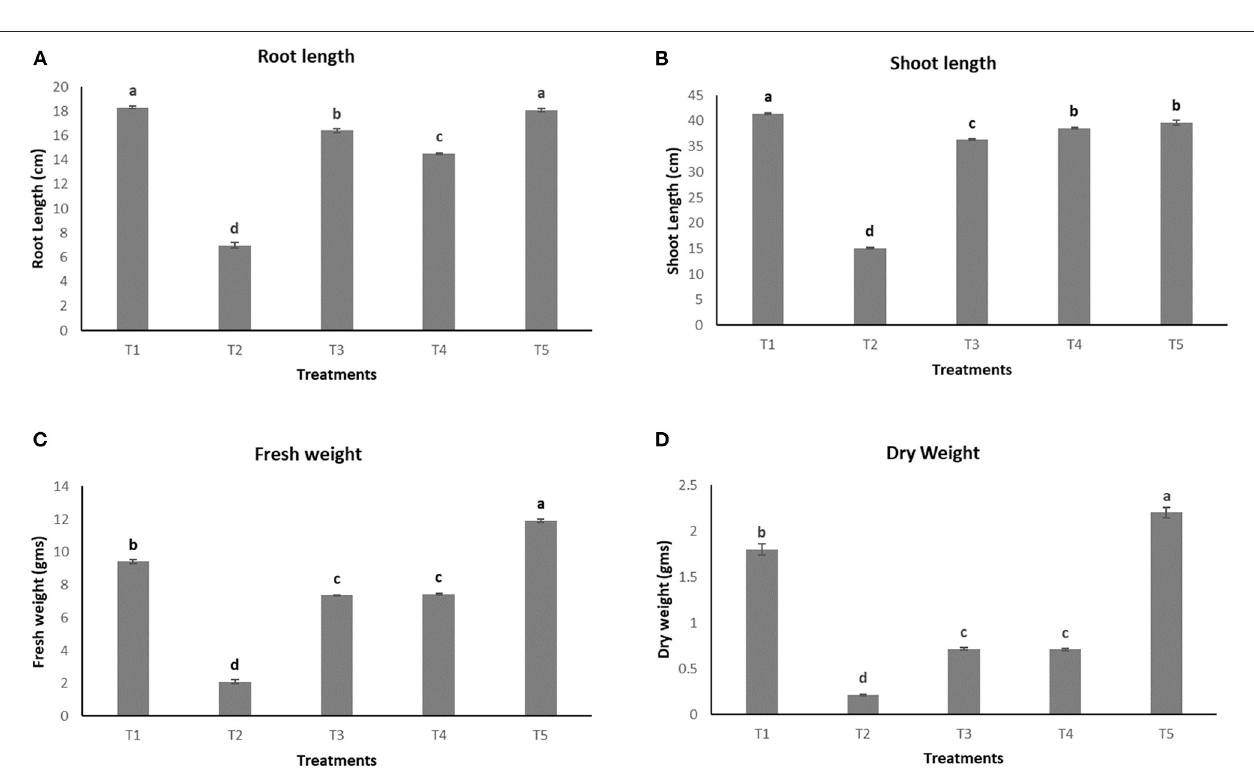
FIGURE 5 | Effect of various treatments on the root length (A) , shoot length (B) , fresh weight (C) , and dry weight (D) of